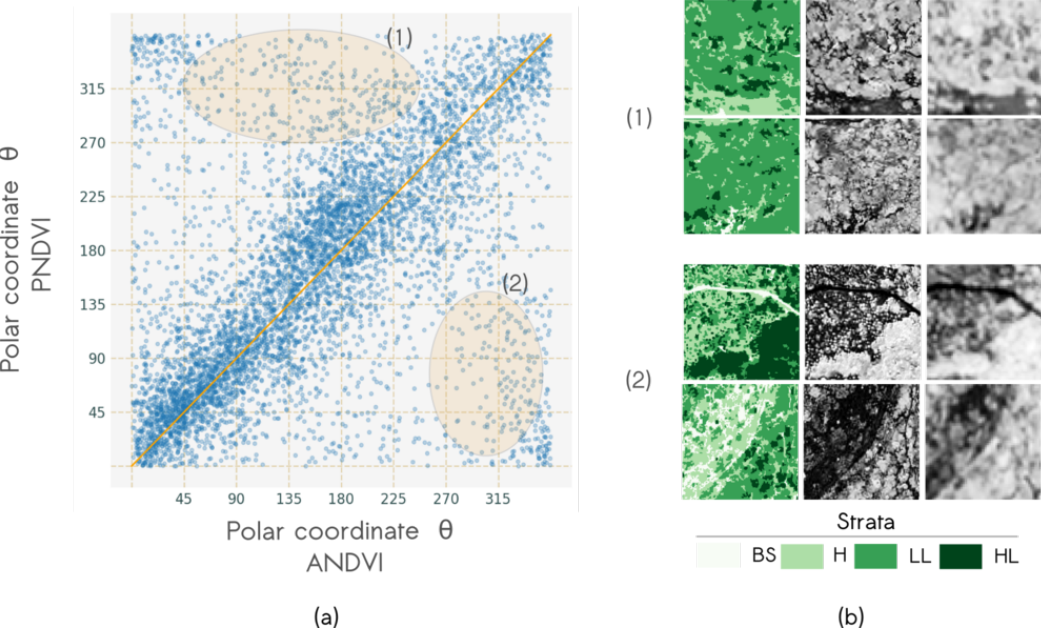
Figure 9. Co-variation of textural gradients derived from airborne imagery NDVI and Pléiades NDVI band: ( a ) Scatterplot of angular coordinates with two types of angular variations highlighted in orange: (1) from [45 ◦ , 225 ◦ ] to [270 ◦ , 360 ◦ ], (2) from [270 ◦ , 360 ◦ ] to [0 ◦ , 135 ◦ ], and ( b ) typical windows of each variation type.